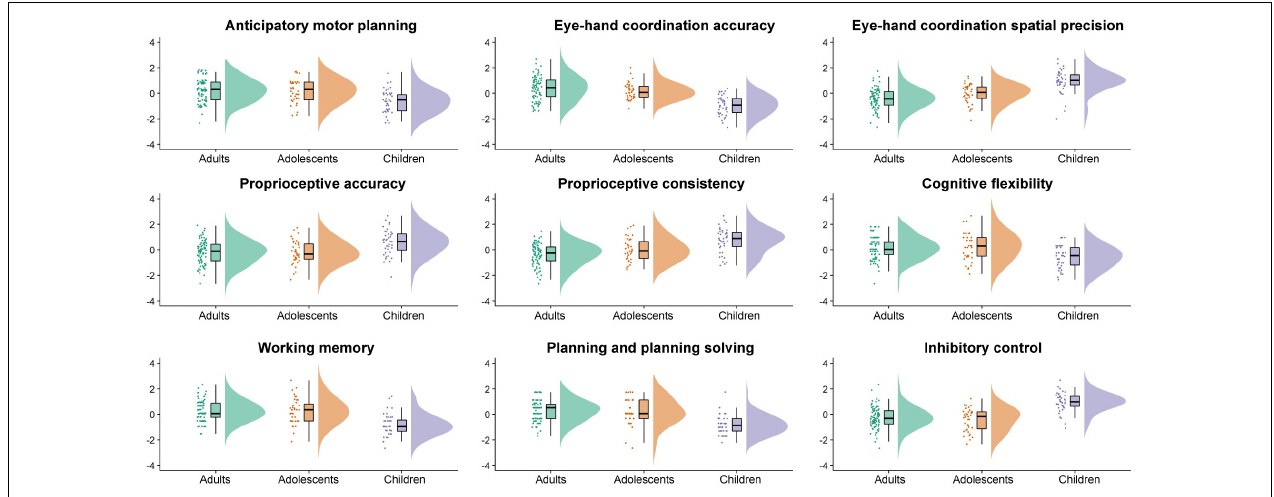
FIGURE 1 | Raincloud plots showing the normalized data, normalized data distribution, and five summary statistics (i.e., normalized median, first quartile, third quartile, minimum, and maximum) for the adults (green), adolescents (orange), and children (purple) for the sensorimotor and executive function variables of interest.